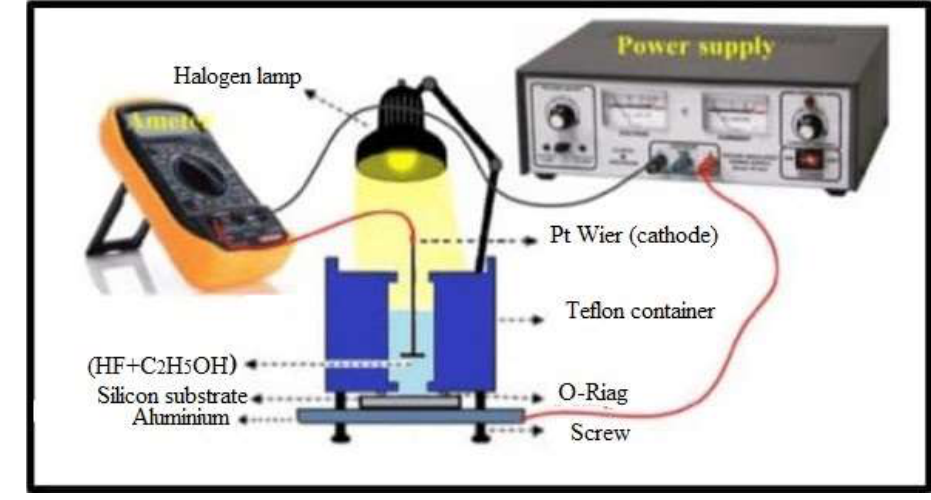
Figure 1: A schematic diagram of PECE set up [12].